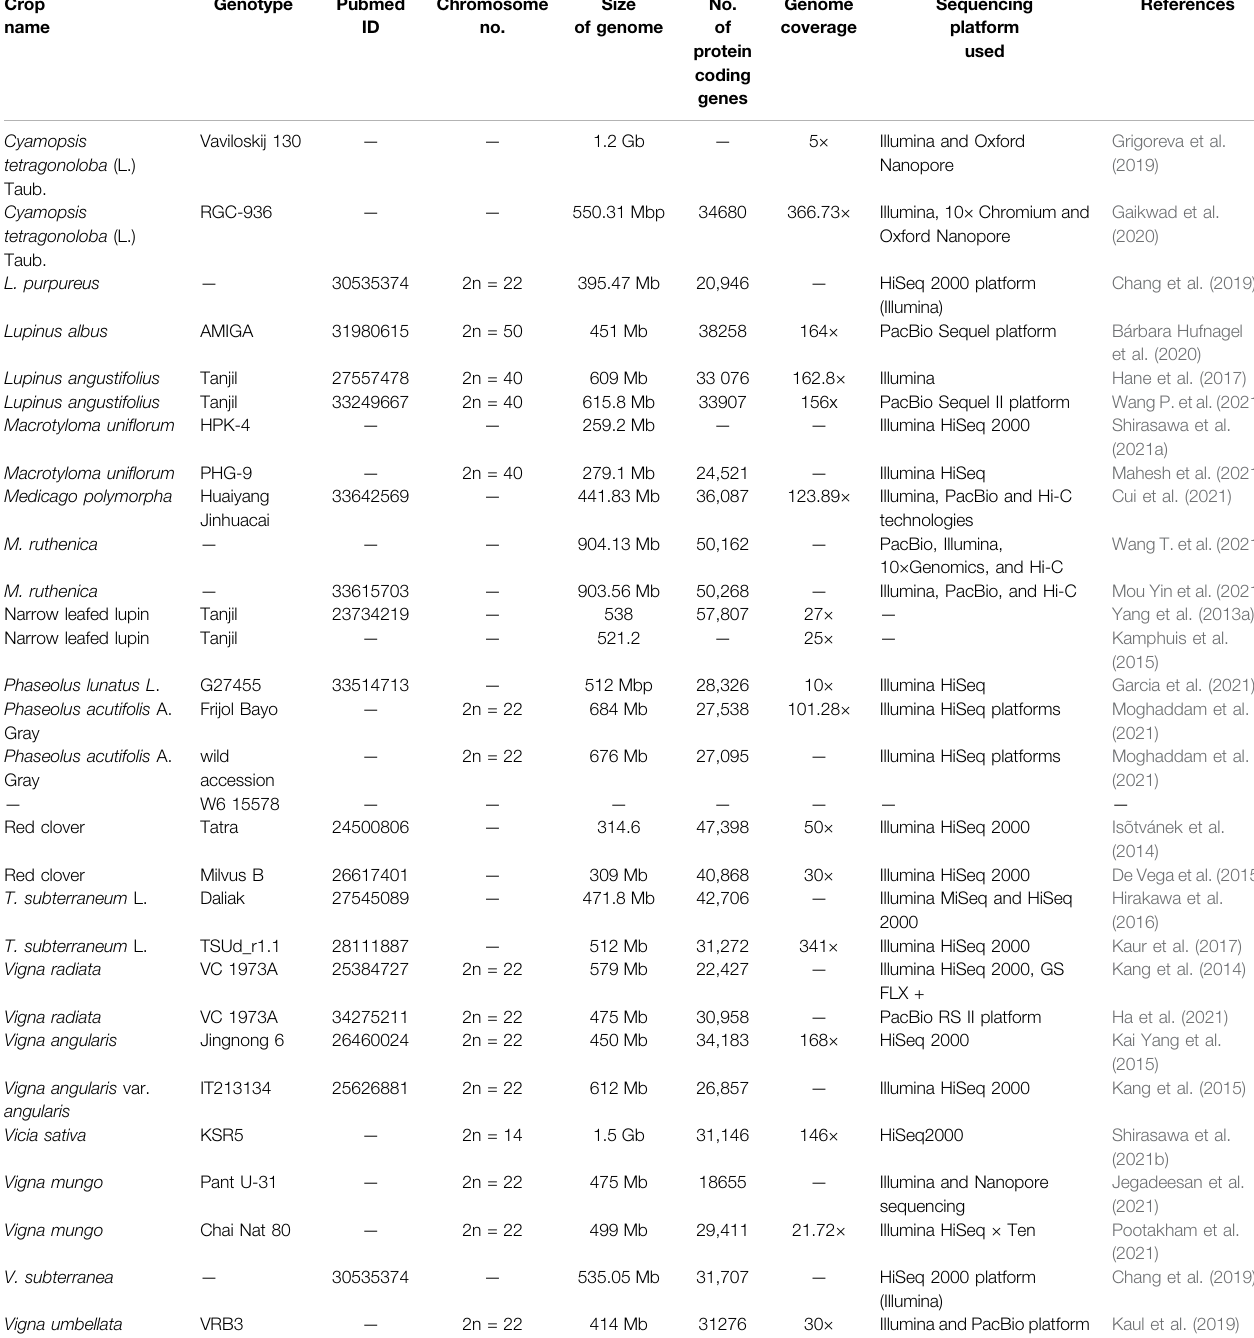
TABLE 2 | List of genome sequence assembly of underutilised legume